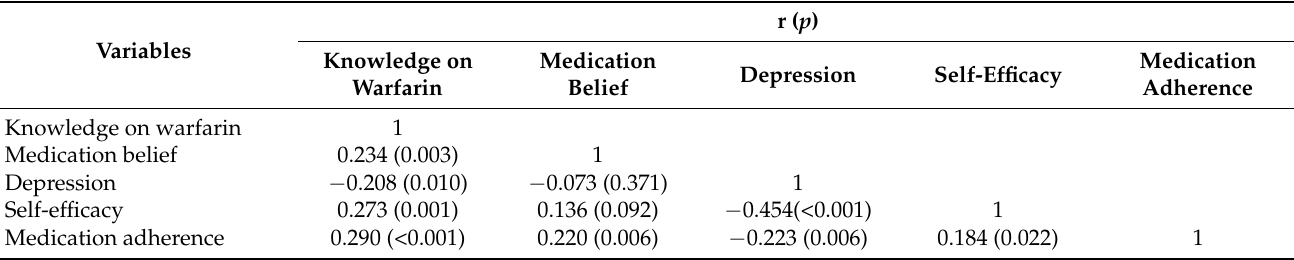
Table 4. Correlations matrix indicating relationships between knowledge on warfarin, medication belief, depression, self-efficacy, and medication adherence (n =